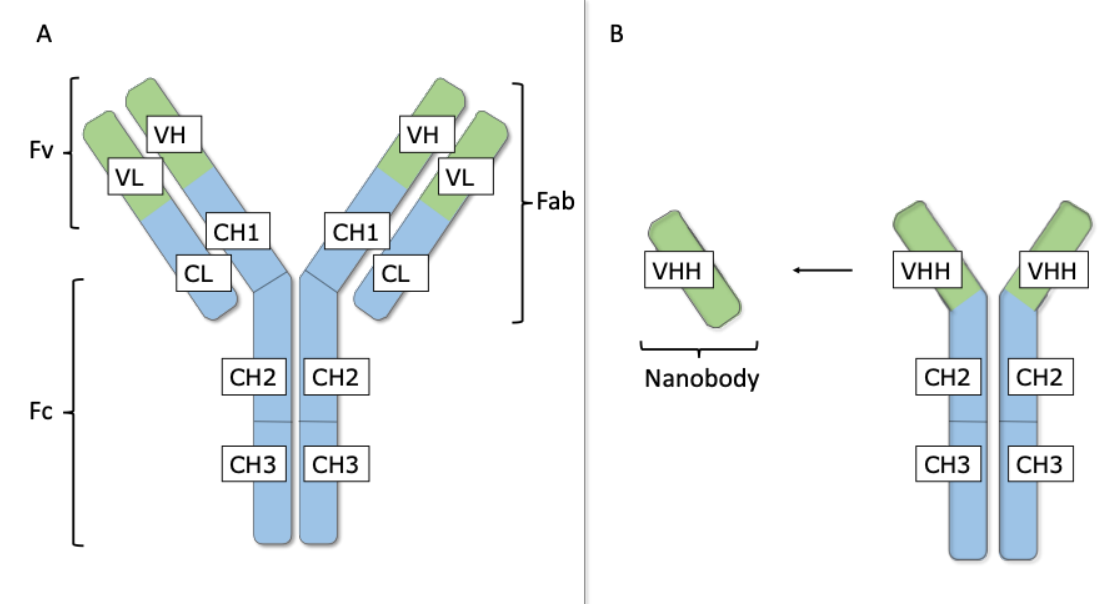
Figure 2. Conventional antibodies and nanobodies. ( A ) Immunoglobulin-G (IgG) with 2 heavy (H) and 2 light (L) chains. The L chain comprises 1 variable (VL) and 1 conserved (CL) domain, whereas the H chain contains 1 variable (VH) and 3 constant (CH1, CH2 and CH3) domains. The paired VH and VL domains form the variable fragment (Fv) and bind to the antigen. The L chain and the first half of the H chain (VH and CH1) are known as the antigen binding fragment (Fab). The CH2 and CH3 domains of the 2 H chains form the crystallizable fragment (Fc). ( B ) Heavy chain-only antibodies (HCAbs) are smaller than conventional antibodies. They are devoid of L chains and the H chain lacks a CH1 domain. HCAbs recognize antigens via the variable domain of the H chain of HCAbs (VHH), also known as a nanobody.